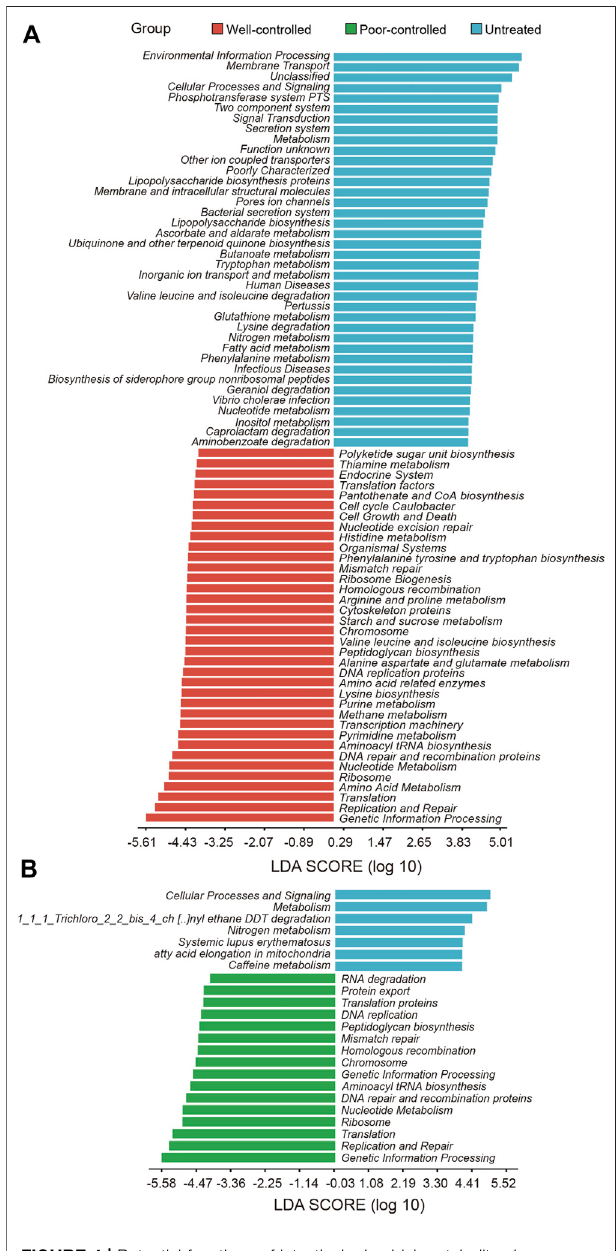
FIGURE 4 | Potential functions of intestinal microbial metabolites in hypertensive individuals receiving ACEI/ARB or not receiving ACEI/ARB. (A) PICRUSt bar plots showing KEGG pathways signi fi cantly shifted in the well- controlled group (red) as compared with untreated patients (blue). Microbial functions targeting inositol metabolism were abundant in untreated patients and decreased in the ACEI/ARB well-control group. (B) Bar plot illustrating the KEGG pathways signi fi cantly distinct between untreated (blue) and poor-controlled group (green). The signi fi cance of different pathways is presented according to the LDA score. These variables with LDA scores (log10) > 2 are listed.